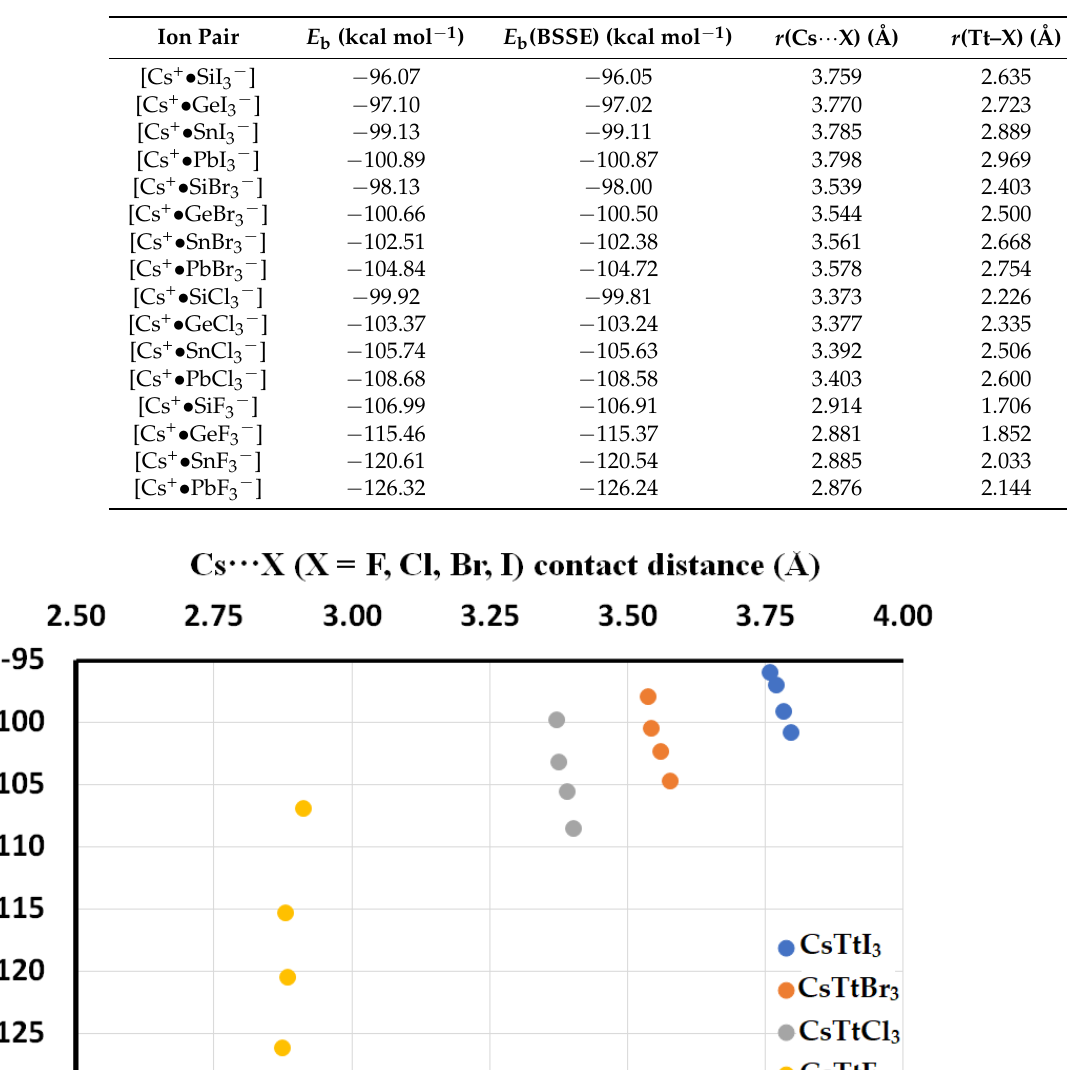
Table 6. The [ ω B97Xd/def2-TXVPPD]-level uncorrected and BSSE-corrected binding energies ( E b and